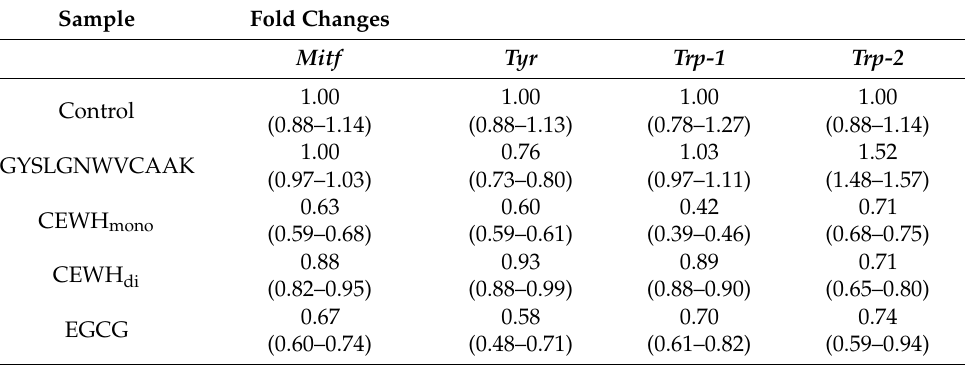
Table 1. Fold change expression of Mitf , Tyr , Trp-1 and Trp-2 genes after treatment with 10 µ g/mL of GYSLGNWVCAAK, CEWH mono , CEWH di and EGCG in B16F10 melanoma